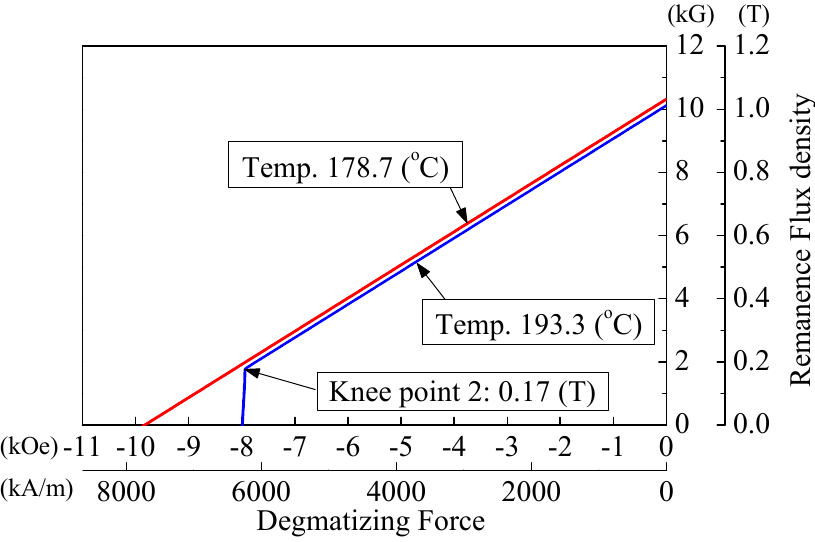
Figure 13. Demagnetization curve (B-H curve in the second quadrant) of the PM.